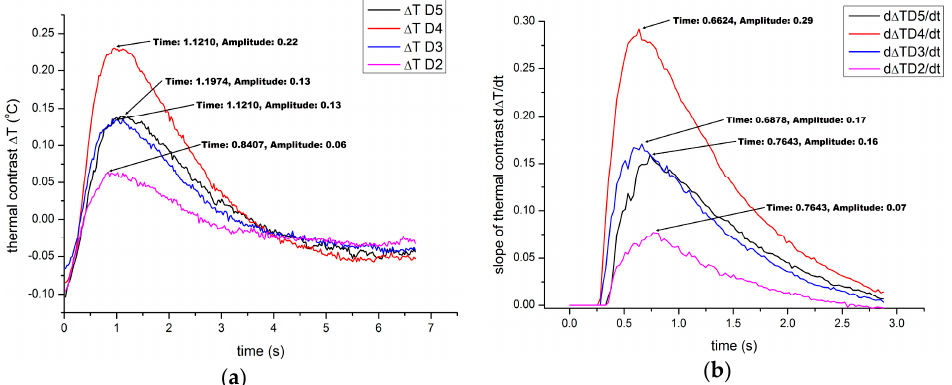
Figure 7. Temporal evolution of: ( a ) the thermal contrast curves; and ( b ) the correspondent slope of the thermal contrasts for the detected insertions on the trapezoid surface located to the depth of 0.8 mm (Series D).